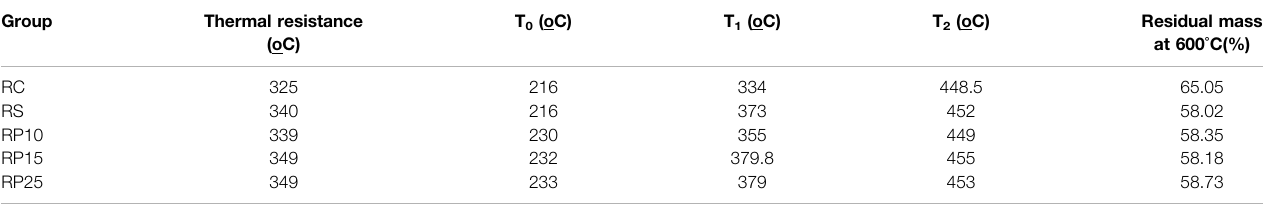
TABLE 6 | Thermal resistance, T 0 , T 1 , T 2 and residual mass at 600 ° C of EABRP enriched composite resins. Group